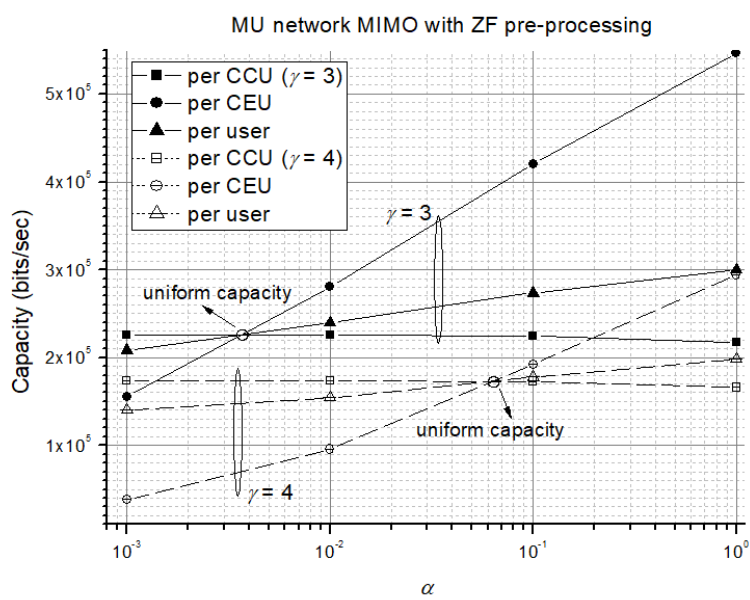
Figure 11. Capacity comparison between different values of path loss exponent γ for MU-network MIMO with ZF joint preprocessing.